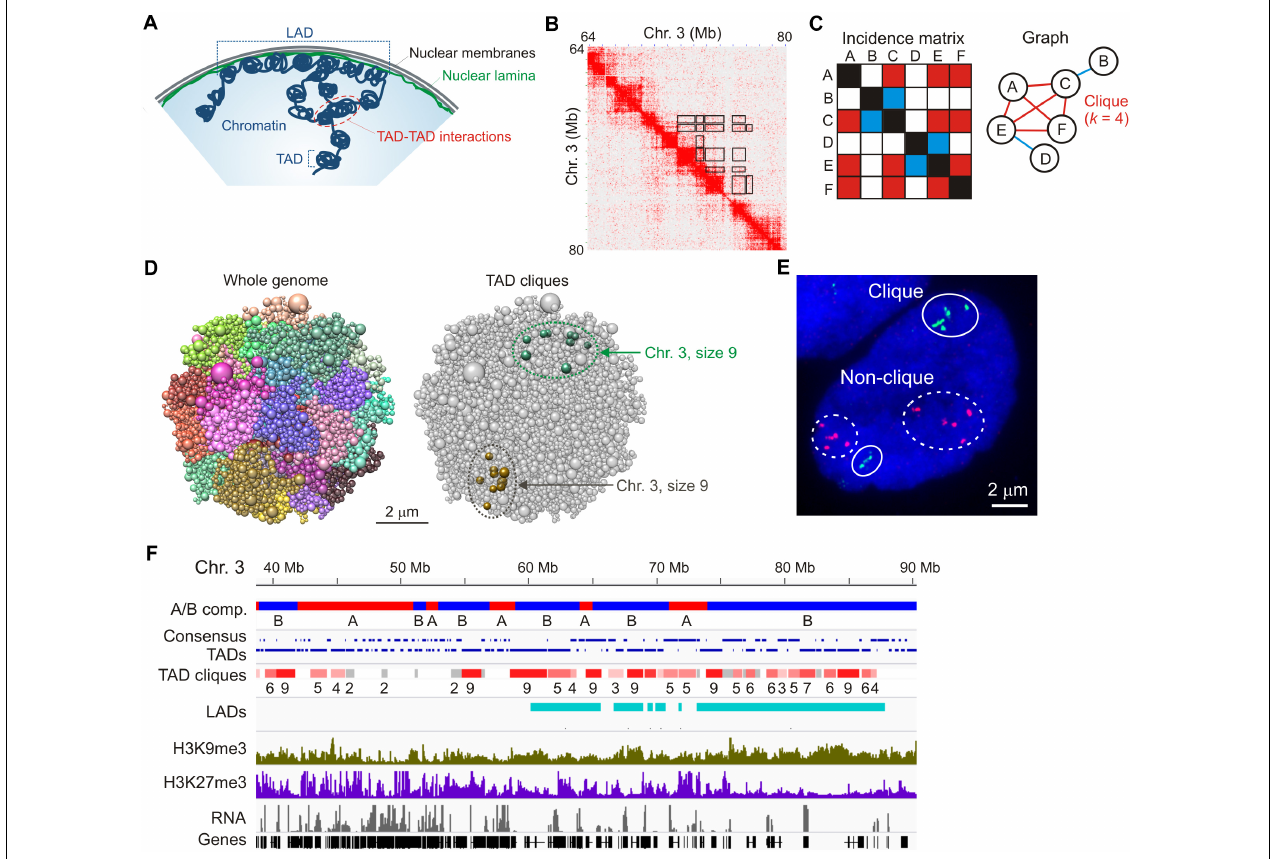
FIGURE 1 | TAD cliques represent spatial assemblies of heterochromatic TADs from Hi-C data. (A) Higher-order chromatin topology in a mammalian nucleus, highlighting a lamina-associated domain (LAD), topologically-associated domains (TADs) and TAD-TAD interactions. (B) Hi-C contact matrix showing TADs along the diagonal and highlighting some of the long-range TAD-TAD interactions, away from the diagonal (black frames); shown here for a region of chromosome 3 in human adipose MSCs. (C) Graph representation of a clique where four vertices (or TADs; A,C,E,F ) all interact pair-wise in the fictive incidence matrix (red cells in the matrix, red edges in the graph). Vertices B and D, respectively, interact with vertices C and E only (blue cells in the matrix, blue edges in the graph) and do not belong to the clique. The clique shown here is of size k = 4. (D) Chrom3D structural models of an MSC nucleus. Models show all chromosomes as a continuous chain of beads (TADs) labeled differently ( left ) and highlight TAD cliques of size 9 on both chromosome 3 homologs ( right ). Note the variation in TAD proximity in both modeled chromosomes. (E) Representative FISH image of six TADs in a clique (green probes; chromosome 1) and five TADs not in clique (red probes; chromosome 5) (see Paulsen et al., 2019 for details). Note the absence of strict physical contact between all TADs even when they belong to a clique in the Hi-C data (green probes). Also note the variation in relative TAD distributions between the two sets of homologous chromosomes. Bar, 2 µ m. (F) Browser view of A and B compartments, consensus TADs (shown over two lines for clarity), TAD cliques with clique size (number of TADs), LADs, H3K9me3, H3K27me3 and gene expression in undifferentiated adipose MSCs. Sequence data can be accessed at NCBI GEO GSE109924 (compartments, TADs, cliques and LADs), GSM621398 (H3K9me3), GSM621420 (H3K27me3), and GSE60237